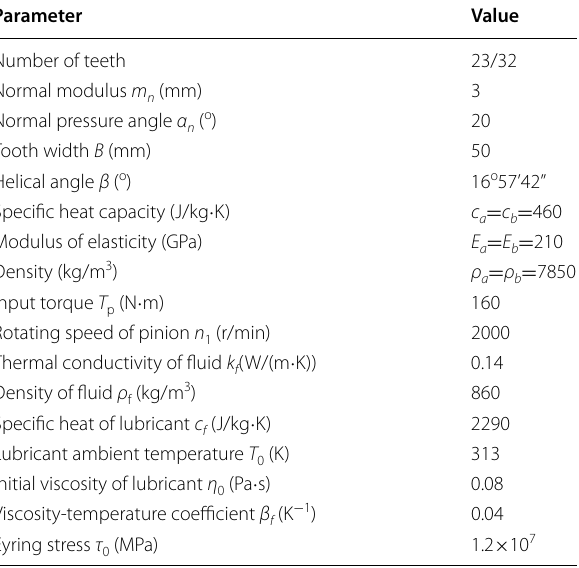
Table 1 Geometric, operating parameters of double involute gears and performance of lubricating oil